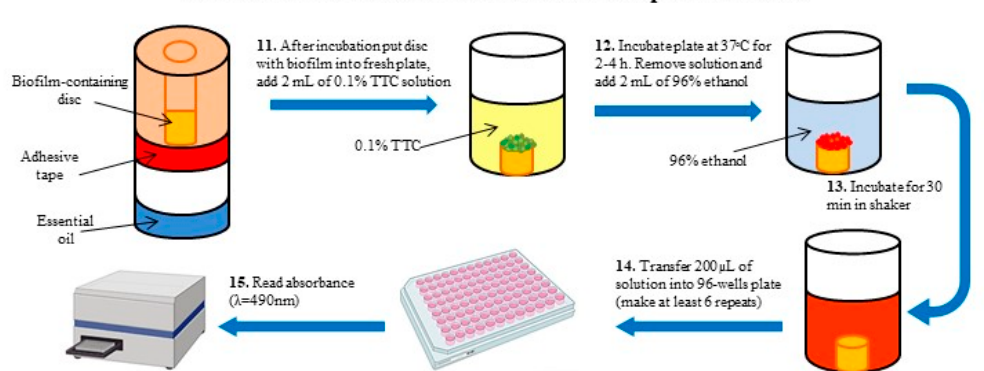
Figure 1. Schematic diagram of AntiBioVol test performance. For picture clarity, the version using the semi ‐ quantitative method of biofilm assessment is presented. For a version using the direct quantitative method (colony forming units counting), please refer to Section 2.2.4 of Materials and Methods. I–III: the main operating blocks of experiment performance.